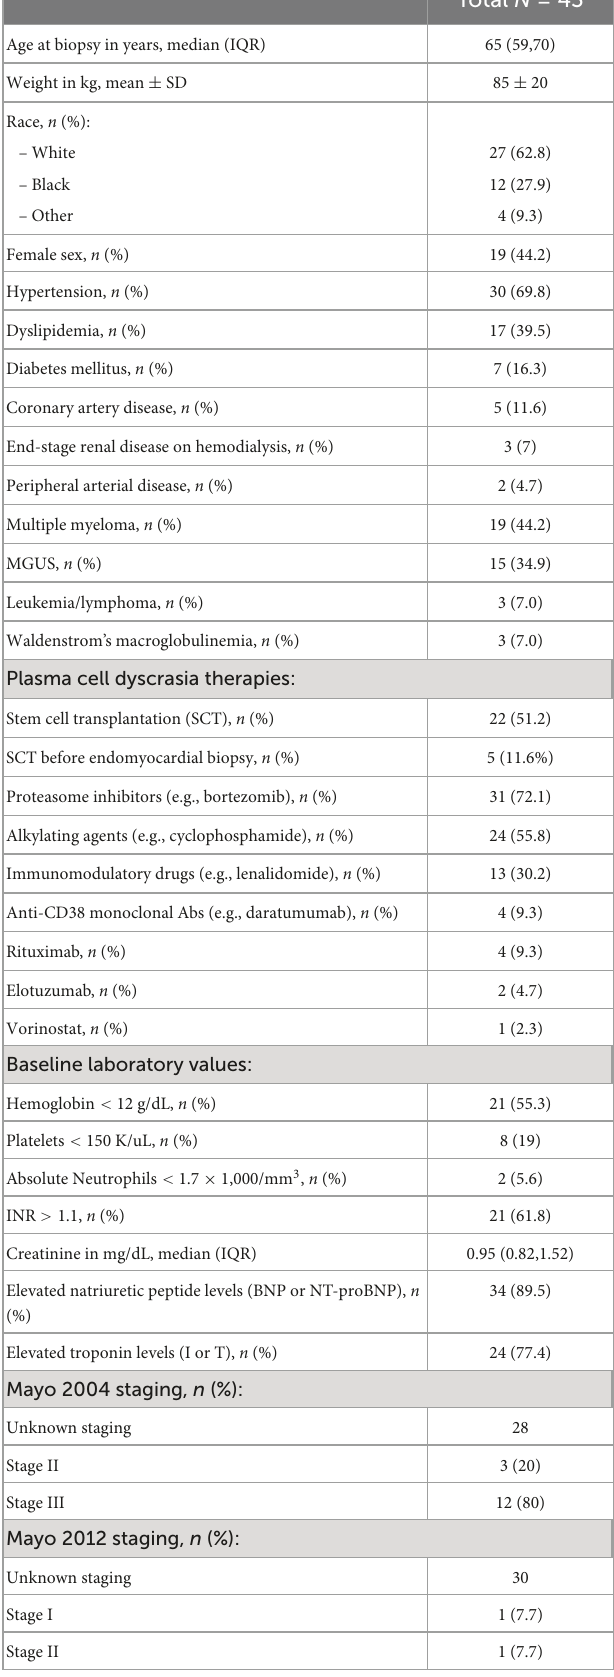
TABLE 1 Demographic and baseline clinical characteristics of 43 patients with endomyocardial biopsy-proven cardiac AL